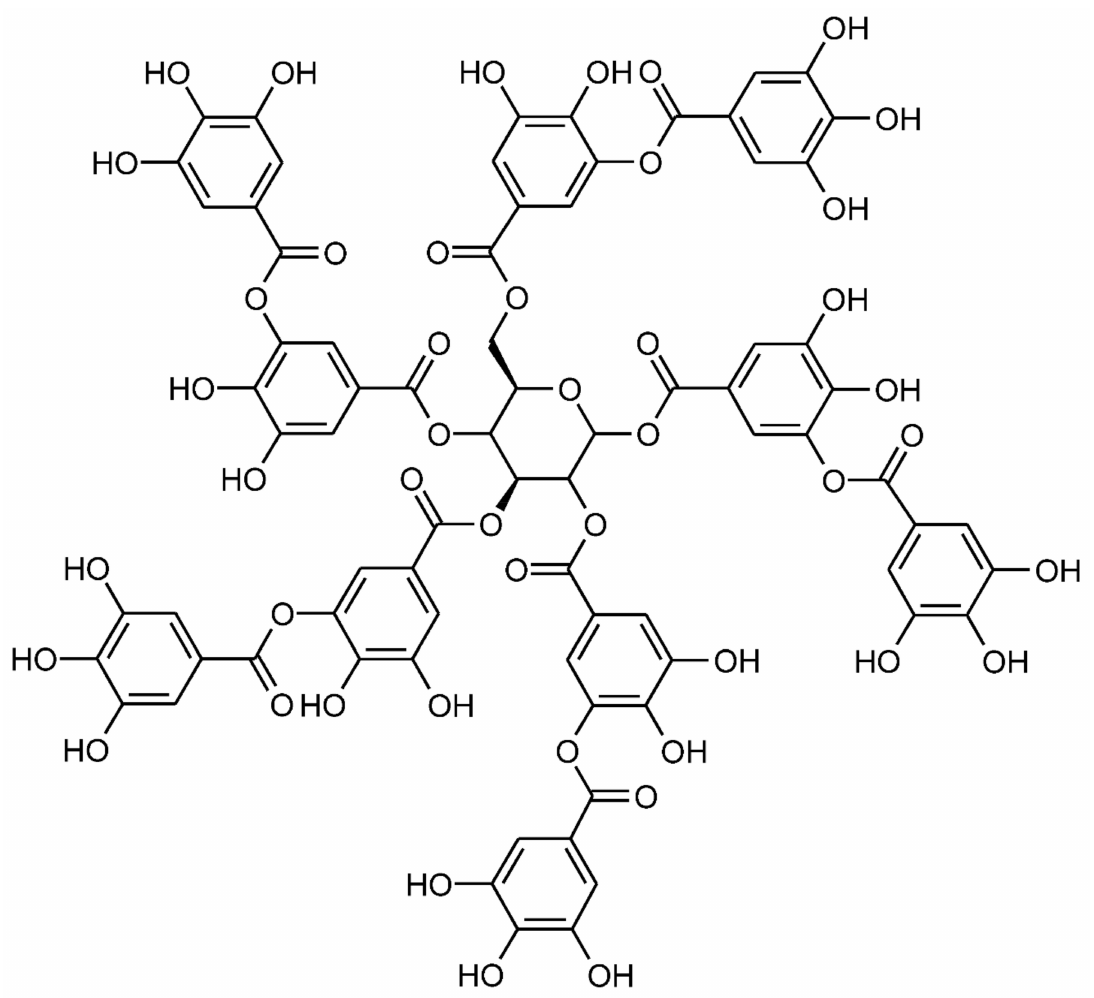
Figure 1. Structure of individual representative ligands capable of binding metal/metalloid ions from various plant phenolic subgroups.